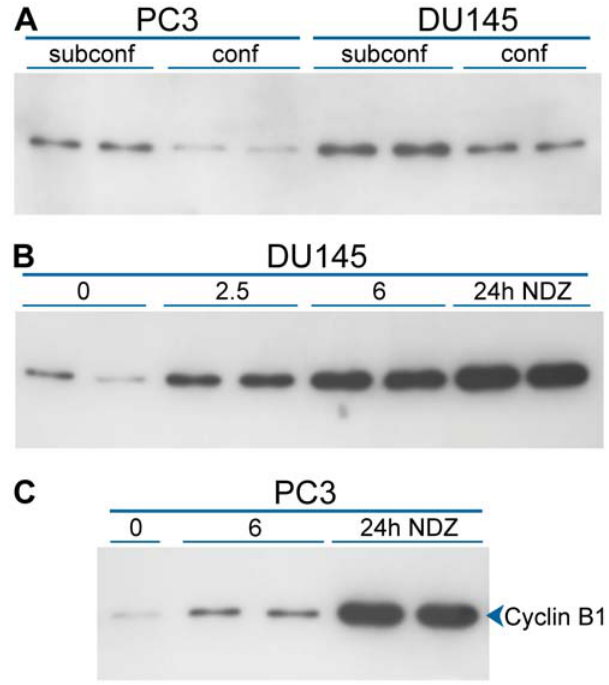
performed. The increase in total cyclin B1 in subconfluent relative to confluent cells was 4.4 fold for PC3 cells and 2.5 fold for DU145 cells ( A ). Nocodazole (NDZ) treatment for the indicated hours produced a final 17.6 fold increase over confluent cells for DU145 cells ( B ) and a 52 fold